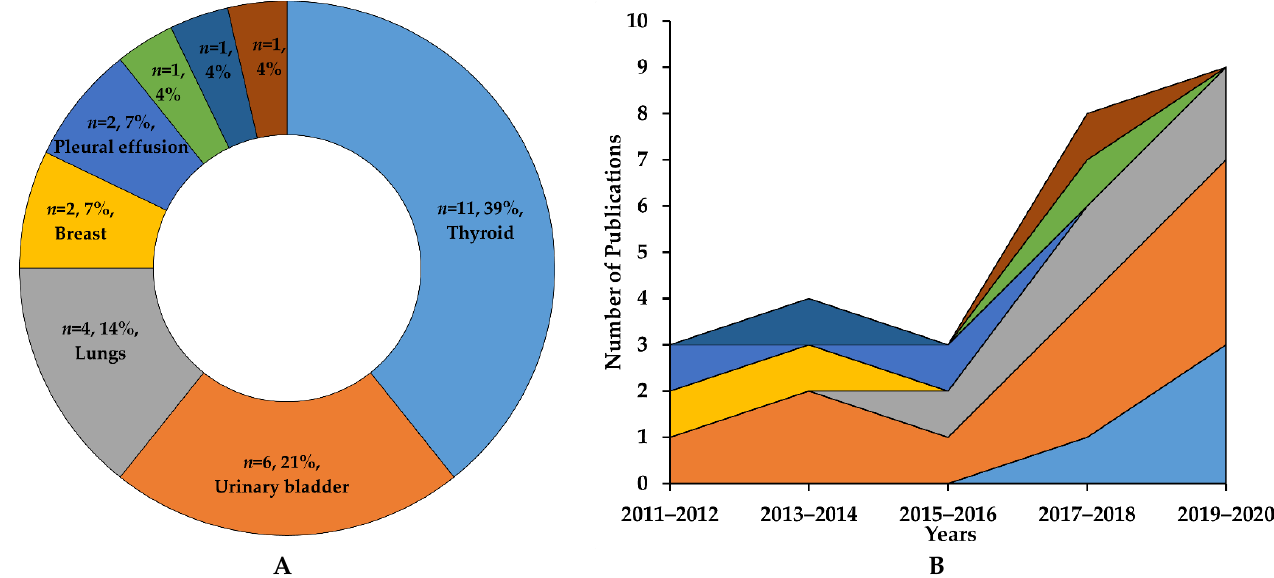
Figure 3. Classification of artificial intelligence models for cytopathological image analysis according to target organ from 2010 to 2020 ( A ) along with yearly trends ( B ).